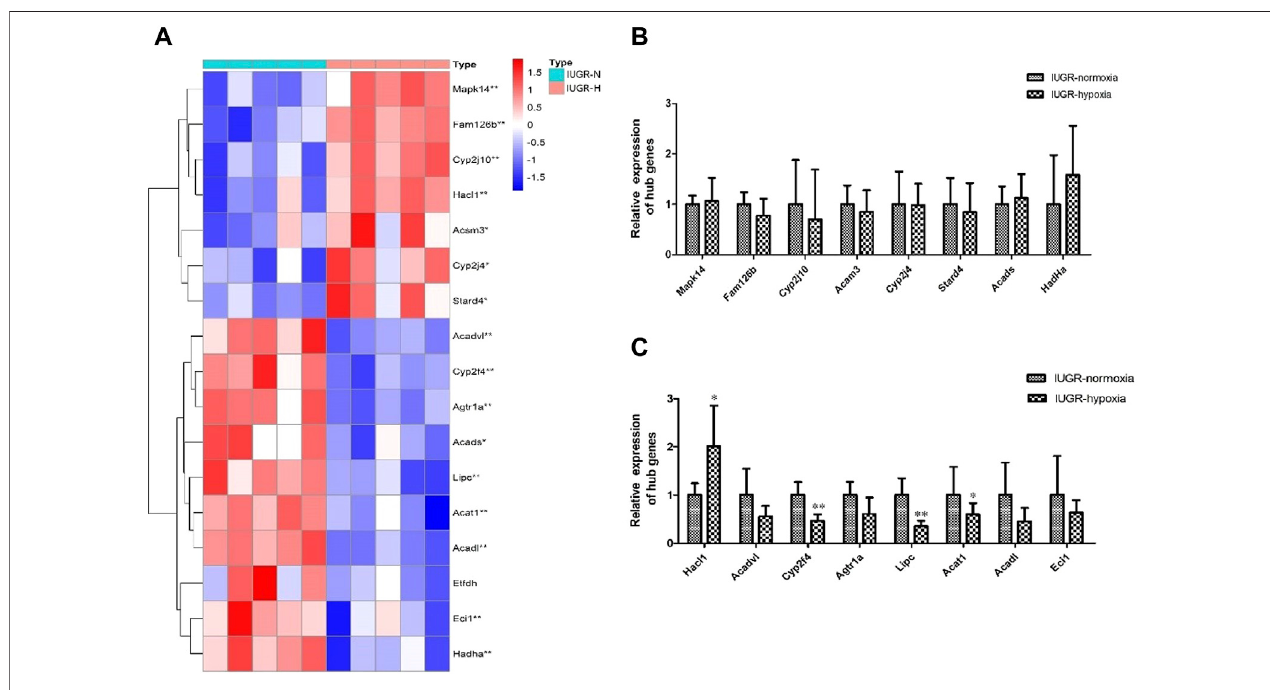
FIGURE 7 | Validation of the hub genes using qRT-PCR. (A) Expression of hub genes between the IUGR-normoxia and IUGR-hypoxia groups. (B) and (C) Validation of the hub genes using qRT-PCR. * p < 0.05, IUGR-normoxia vs. IUGR-hypoxia. ** p < 0.01, IUGR-normoxia vs.